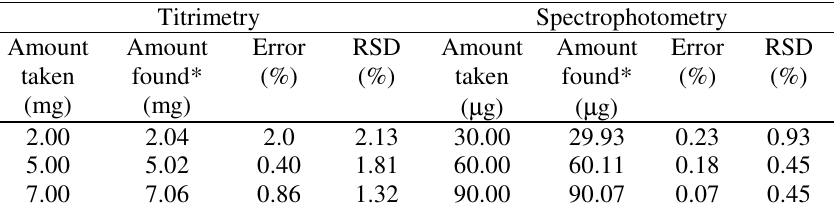
Table 1. Evaluation of accuracy and